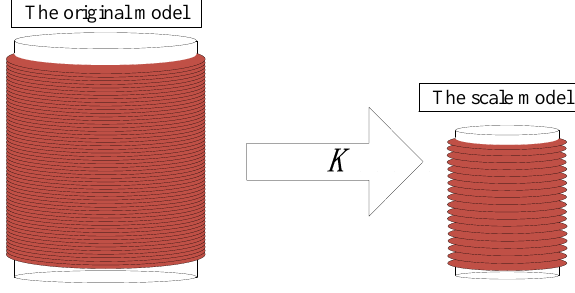
Figure 14. Original model and small-scale model I.